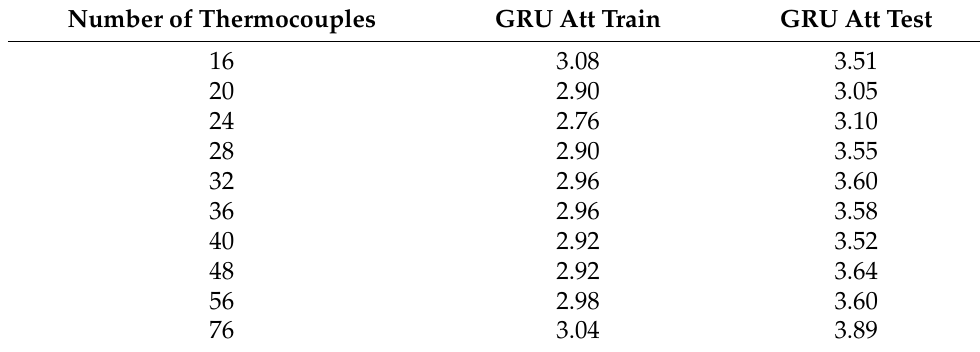
Figure 14. Average RMSE behavior when increasing the output thermocouples to predict. Table 9. Average RMSE results when increasing the number of thermocouples to predict in the GRU attention